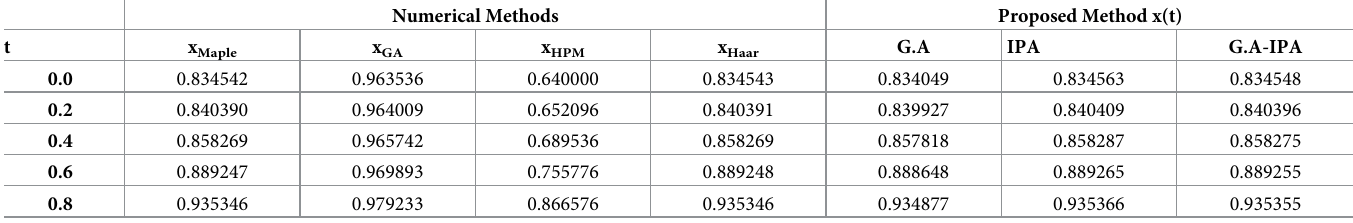
Table 5. Approximate solutions by numerical methods and proposed method for δ =